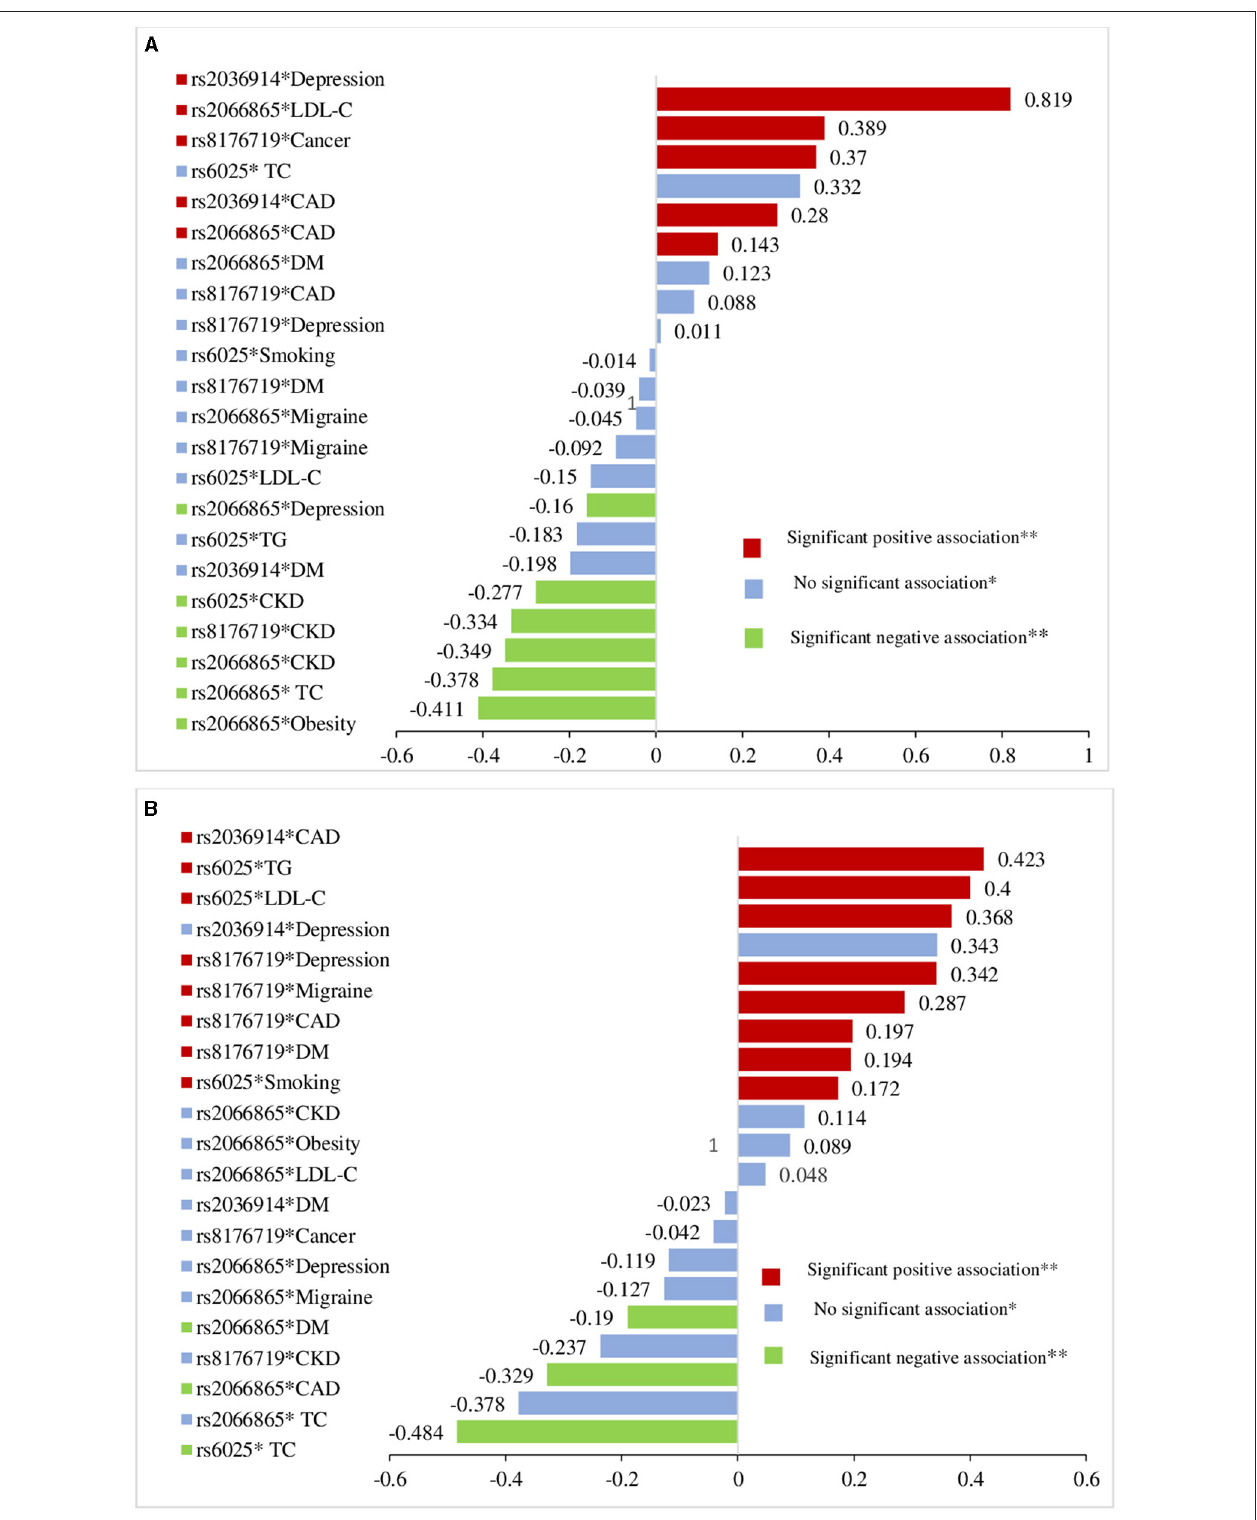
FIGURE 3 | Comparison of G × E on the VTE risk among Roma population (A) and general Hungarian (B) based on standardized linear regression coefficients from multivariate linear regression analysis after interaction terms included between genes and VTE risk factors.